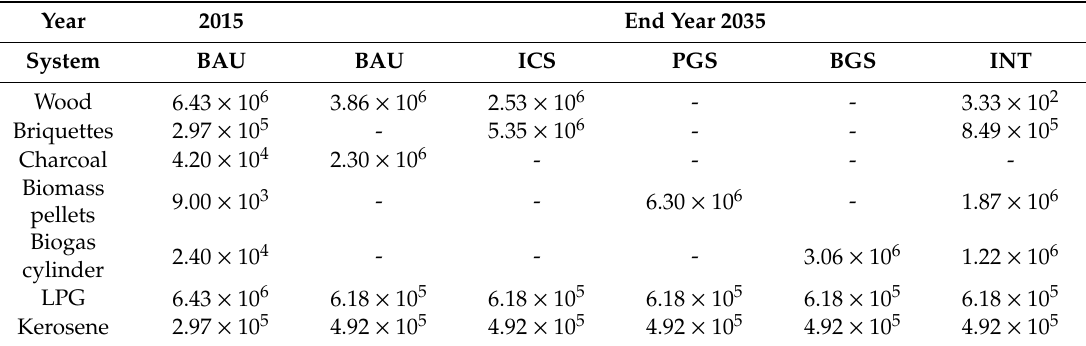
Table A3. Material / distance inputs in the fuel transport life-cycle stage (tkm 1 ) for each fuel system in urban areas.